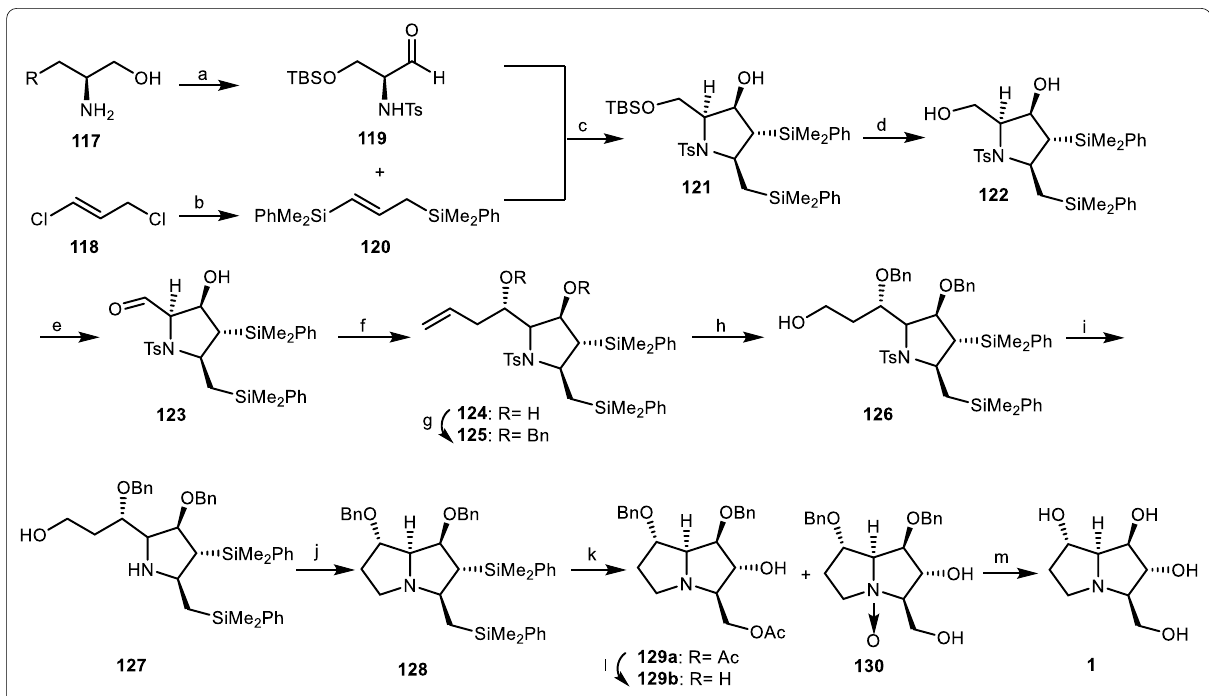
Scheme 10 The synthesis of the alexine 1 by Somfai et al. Reagents and conditions: (a) ref [46]; (b) ref [47]; (c) MeAlCl 2 , CH 2 Cl 2 , dr); (d) AcOH,